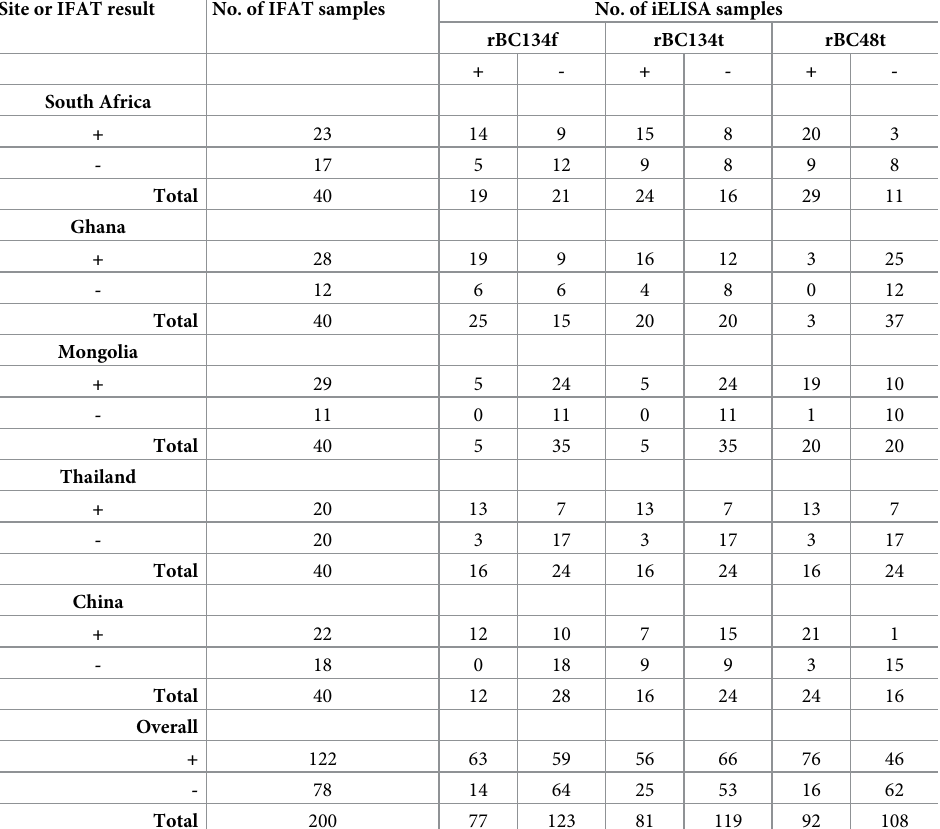
Table 2. Summary of iELISA and IFAT results with single recombinant protein results using field sera collected from different locations endemic for B . caballi . Site or IFAT